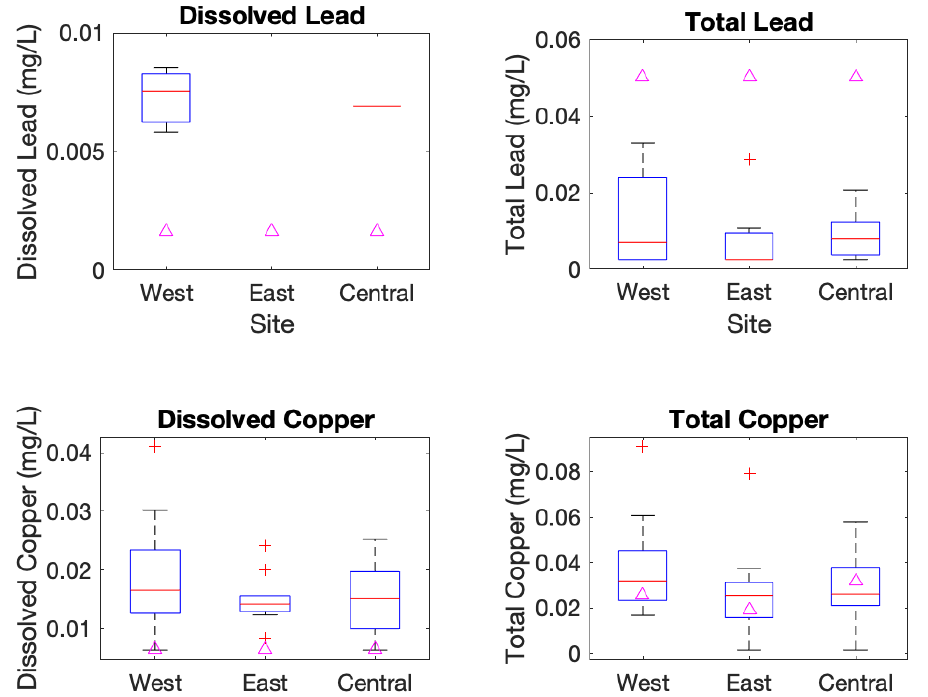
Figure A5. Wet weather water quality—copper and lead boxplots. Red plus signs indicate outliers and triangles represent CDPHE in-stream standards, where relevant.